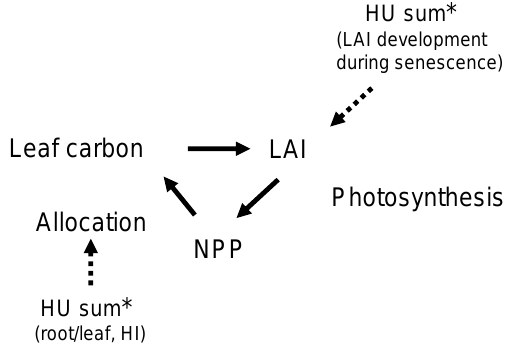
Fig. 1. Crop phenology in LPJ-GUESS. The feedback between leaf area and leaf carbon mass via NPP is denoted by full-line arrows and the heat unit sum control of the carbon allocation and LAI is denoted by dotted arrows. ∗ HU sum: heat unit sum (dynamic poten- tial HU adapted to local climate); LAI: leaf area index; HI: harvest index; NPP: net primary production.